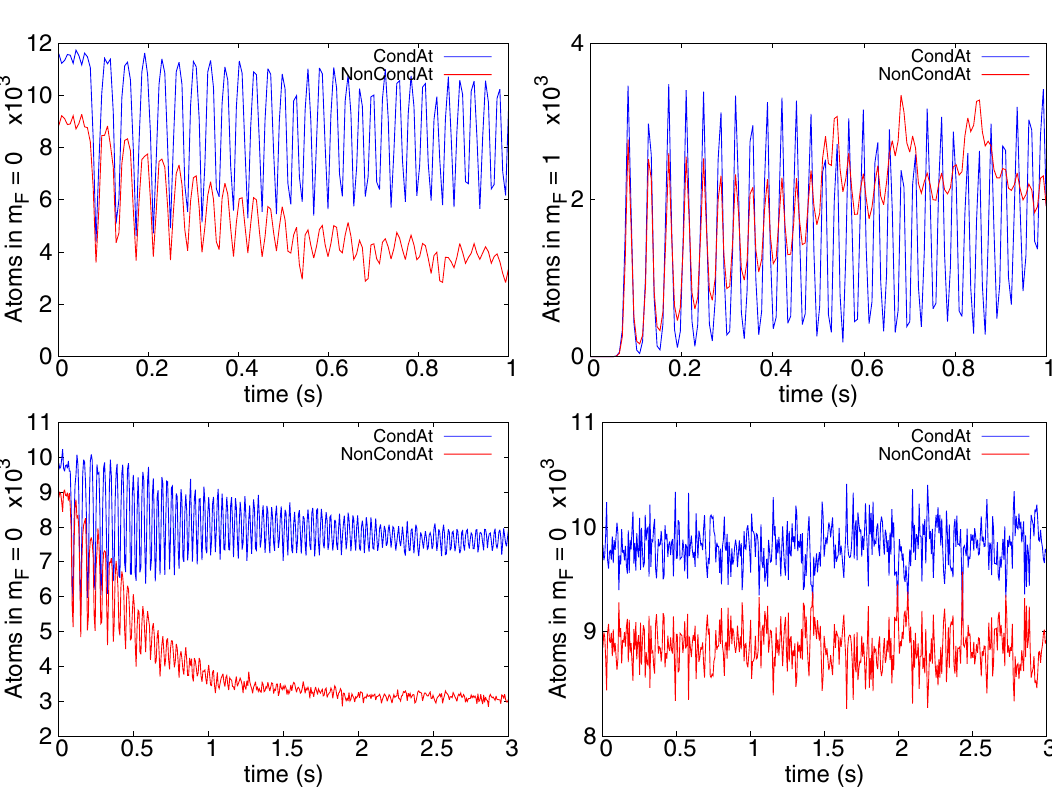
Figure 6. Condensate and thermal fraction occupations for 23 Na simulations. The top row shows the first cycle 0.011 (cid:31) ω x (B = 100 mG) from Fig. 5, with m F 0 populations on the left, m F of the simulation with q = = 285 mG, q 0 populations for: B 0.09 (cid:31) ω x on the left (below on the right. The bottom row shows m F = = = 425 mG, q 0.2 (cid:31) ω x on the right (above threshold). In all cases condensate occupations are threshold) and B = = in blue, thermal cloud in